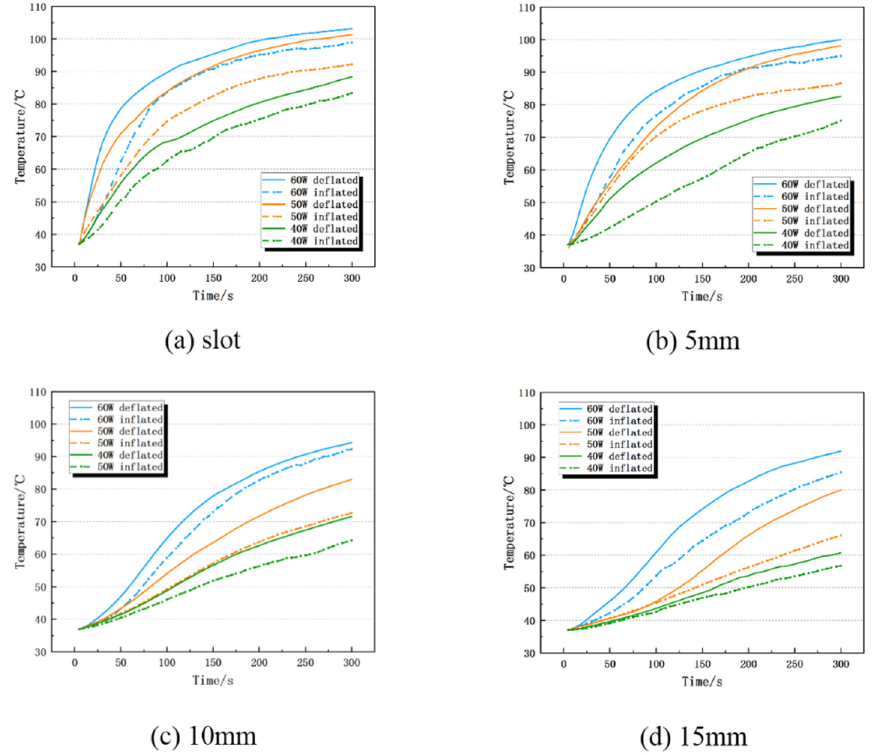
Figure 7. Temperature curve of lung tissue at different locations of slot. ( a ) antenna slot ( b ) 5 mm away from the slot ( c ) 10 mm away from the slot ( d ) 15 mm away from the slot).